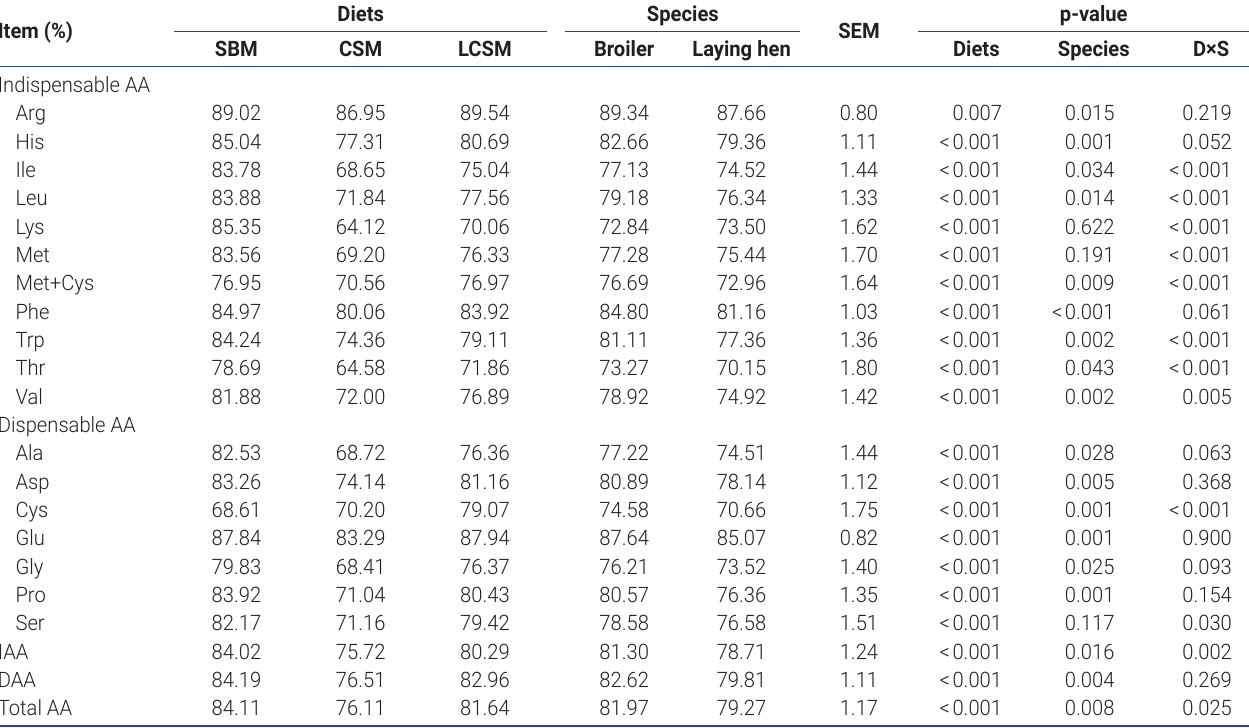
Table 7. Comparison of standardized ileal digestibility of AA between broilers and laying hens fed different ingredient